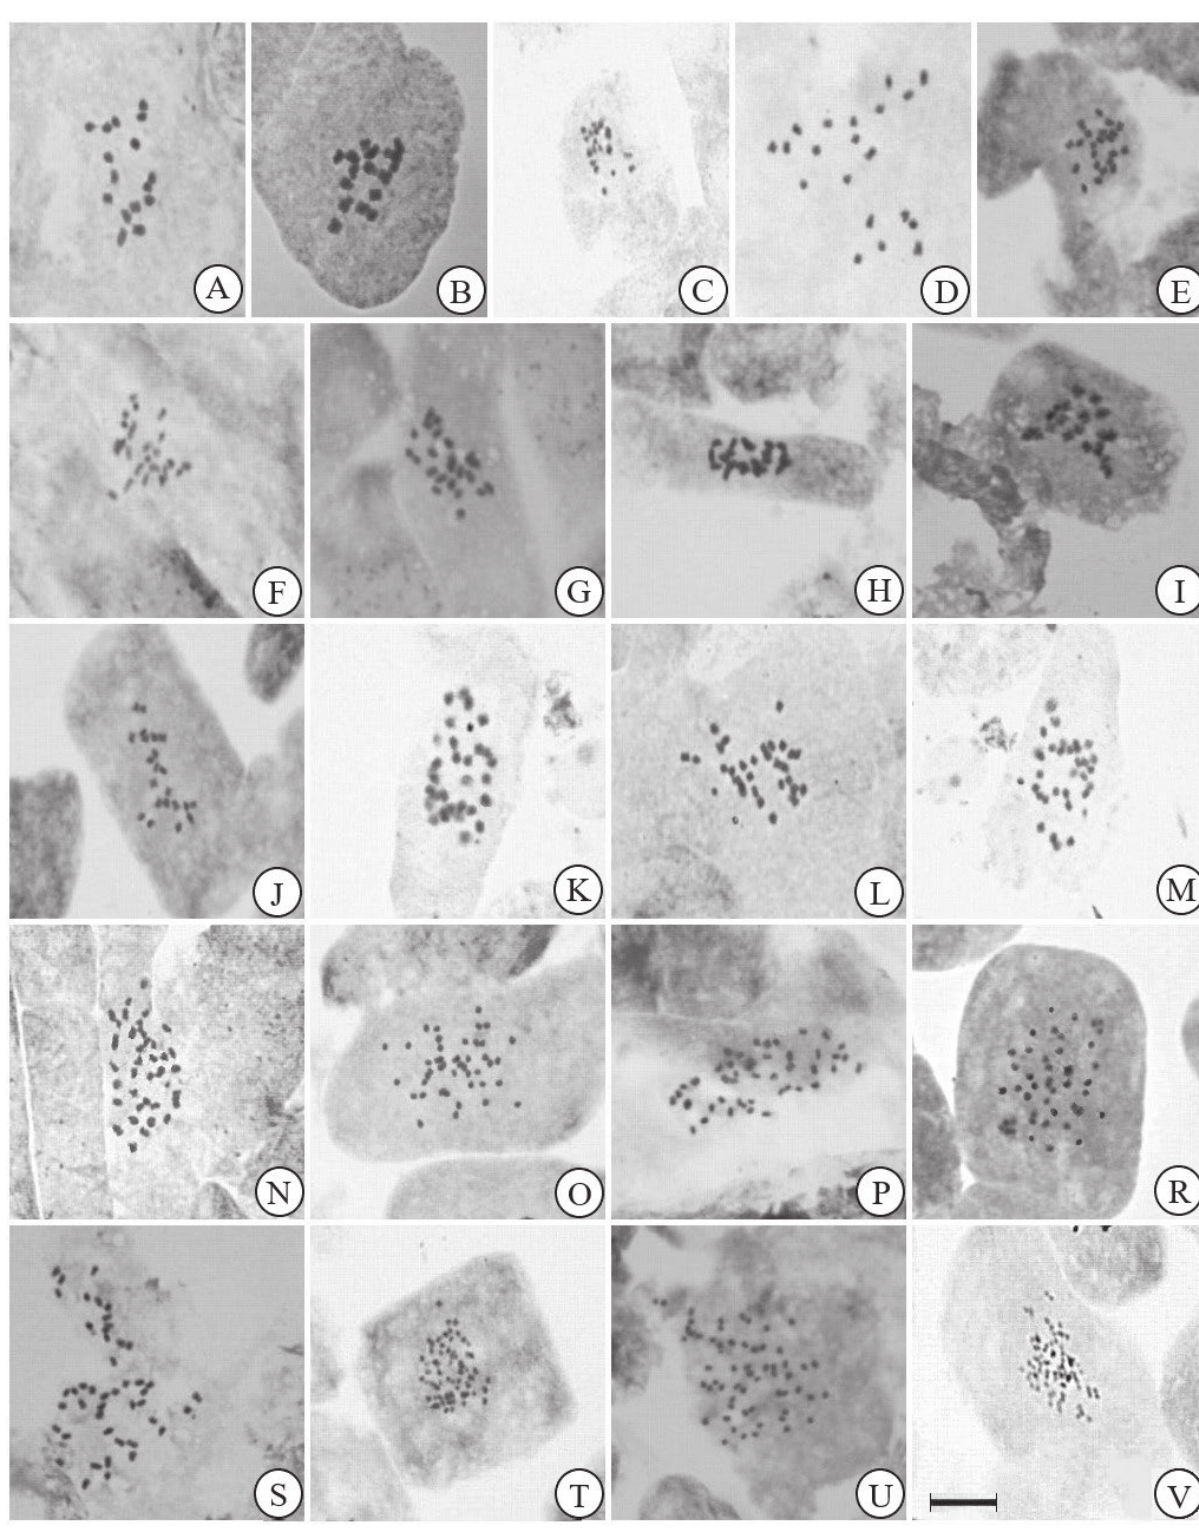
Figure 1. Mitotic metaphase chromosomes of Salvia : (A) S. corrugata , (B) S . campanulata , (C) S . curviflora , (D) S . elegans , (E) S . darcyi , (F) S . greggii , (G) S . involucrata , (H) S . longifolia , (I) S . vitifolia , (J) S . mexicana , (K) S . apiana , (L) S . leucophylla , (M) S . mellifera , (N) S . cardiophylla , (O) S . cuspidata , (P) S . splendens , (R) S . subrotunda , (S) S . microphylla , (T) S . oppositiflora , (U) S . stolonifera , (V) S . atrocyanea (scale bar: 10